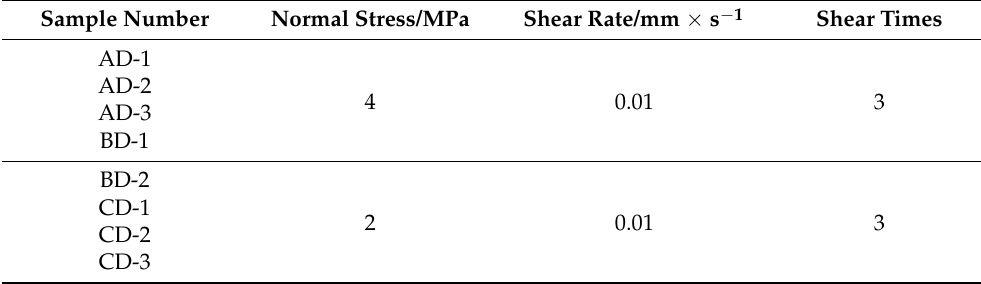
Table 2. The test loading scheme of rock–mortar